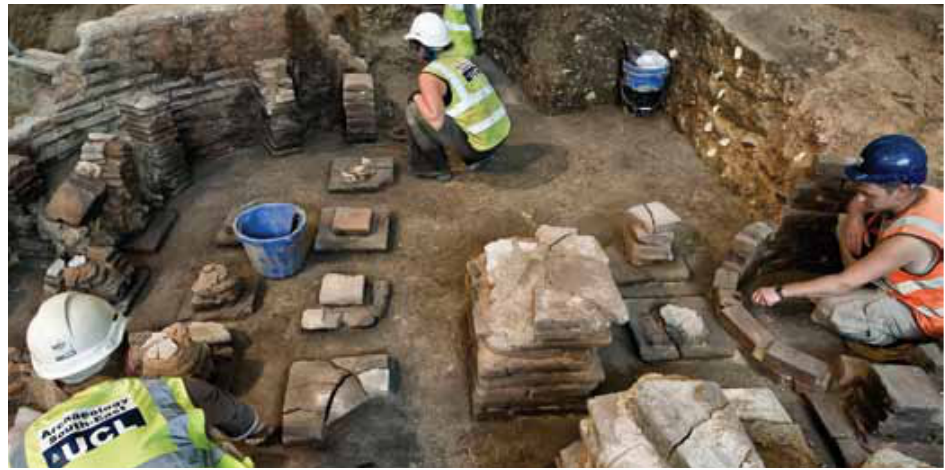
Fig. 1: The Roman baths at Tower Street, Chichester being cleaned for display within Chich- ester